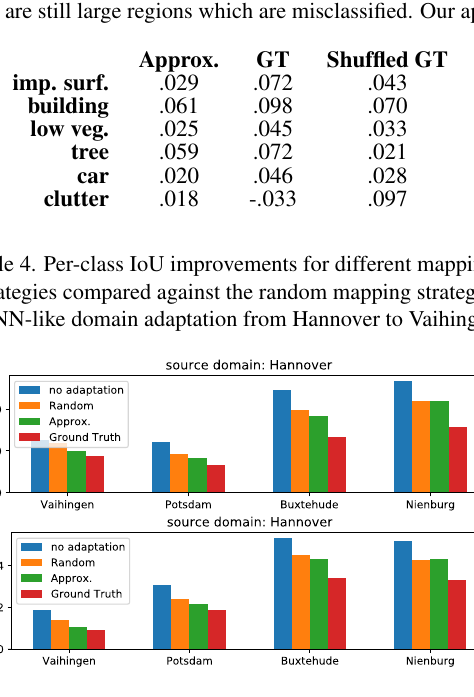
Figure 11. Accuracy and mIoU loss of DANN-like domain adaptation with Hannover as a source